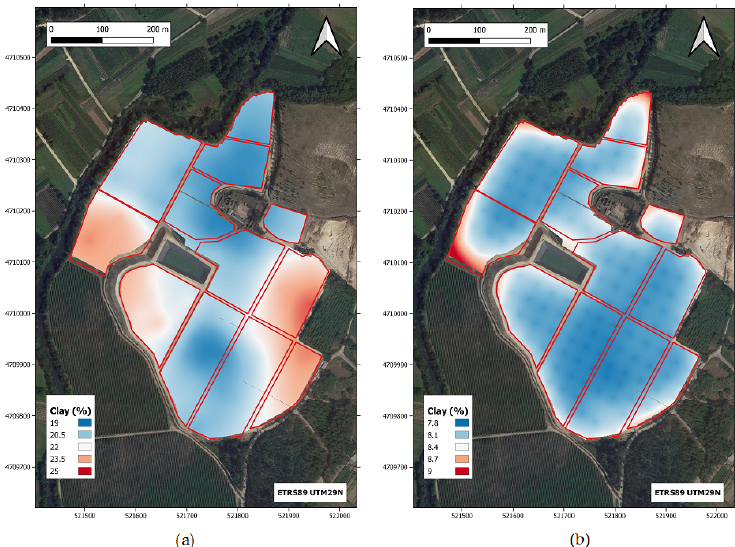
Figure 8. Estimation ( a ) and error ( b ) maps of clay content over the experimental vineyard generated by ordinary kriging.